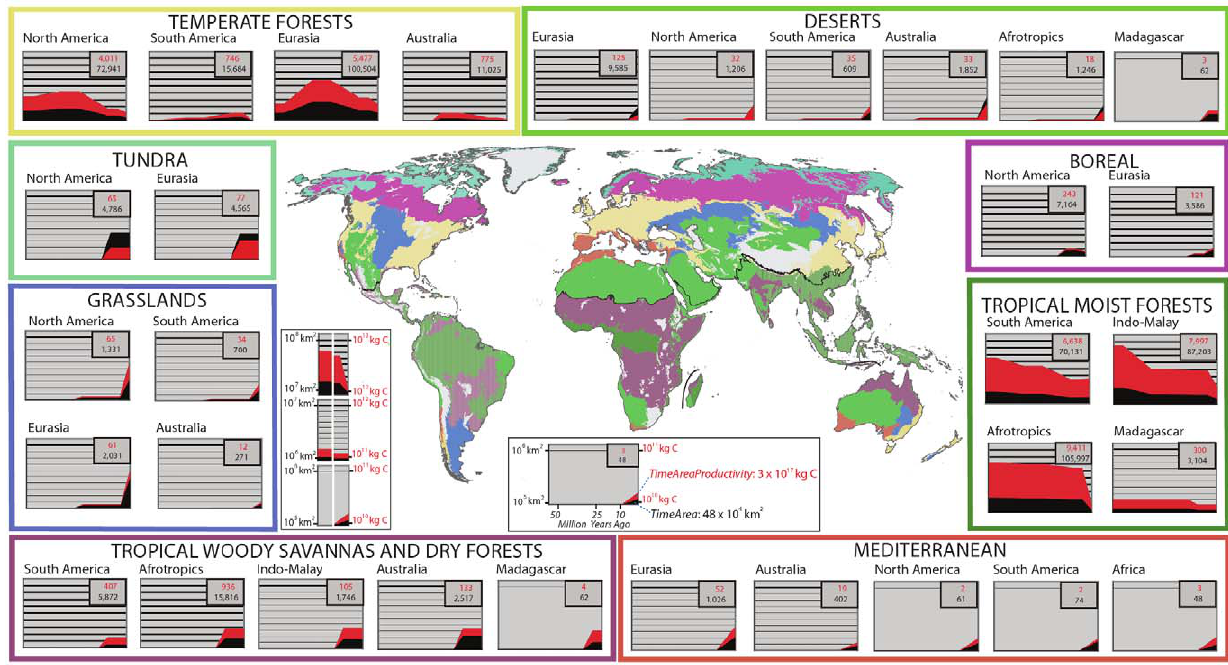
Figure 1. Map of study bioregions and their area and annual productivity dynamics. The variation in area (black) and annual productivity (red) over the last 55 million years forms the species richness predictors TimeArea (cumulative time-area, units 10 4 km 2 6 million years) and TimeAreaProductivity (cumulative total productivity, units 10 17 kg Carbon), respectively (values in upper right box corner). Panel boxes have one of three different y -axis scales (note different line thicknesses and legend). For example, in tropical woody savannas and dry forests, the land area for the last few million years has been , 1 6 10 7 km 2 in the Afrotropics, , 2 6 10 6 km 2 in Australia, and , 1 6 10 5 km 2 in Madagascar. See also Tables S1, S2, and